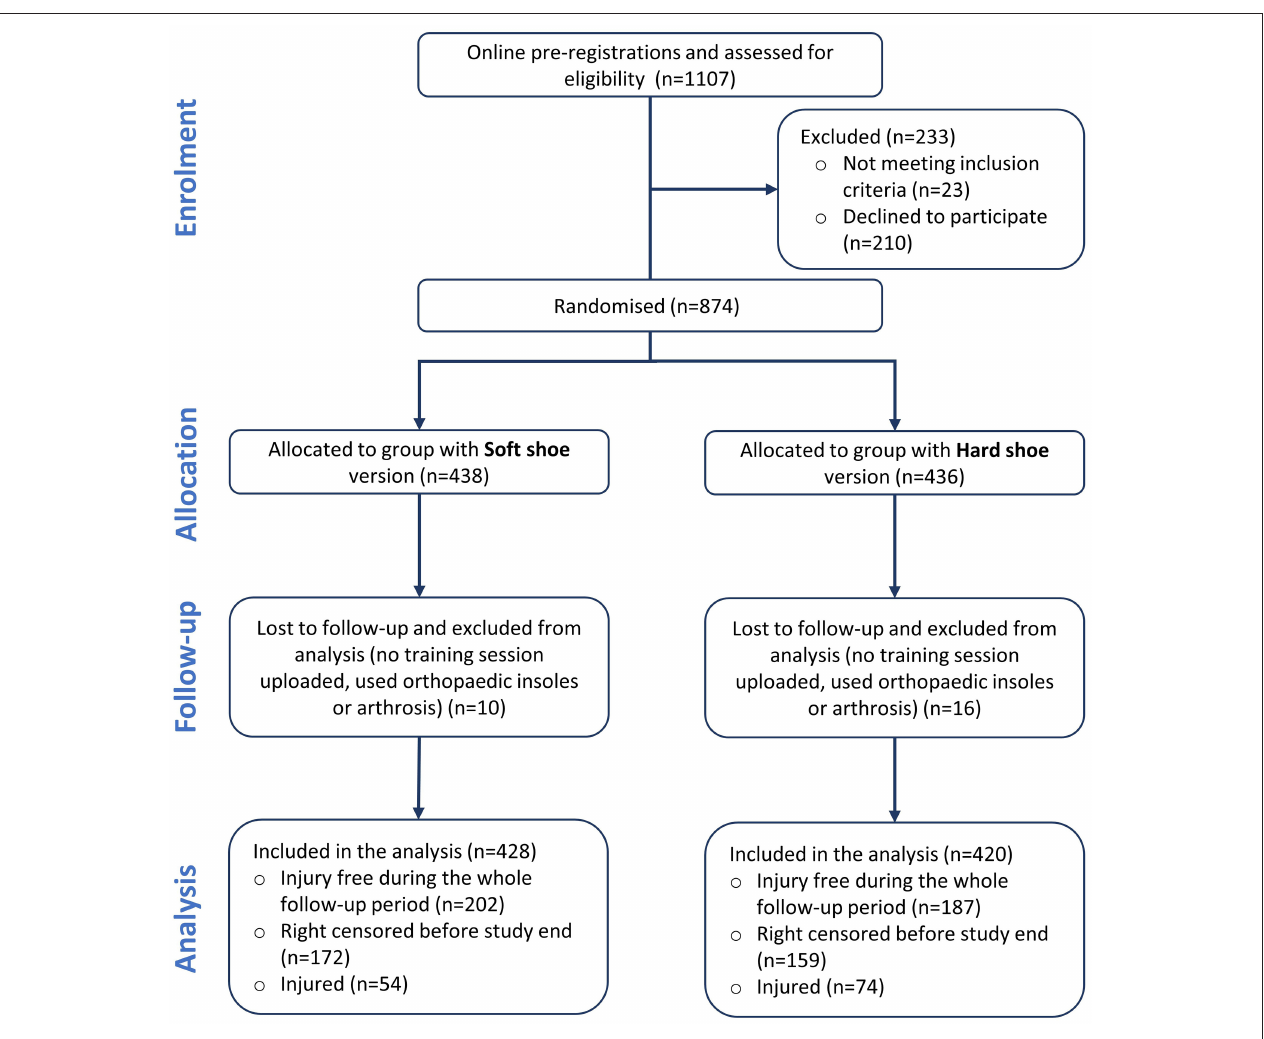
FIGURE 3 | Flow chart of volunteers and study